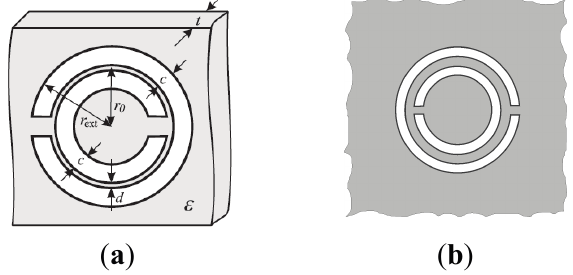
Figure 1. Typical topology of a metallic split ring resonator (SRR) ( a ), and complementary SRR (CSRR) ( b ). The relevant dimensions are indicated in